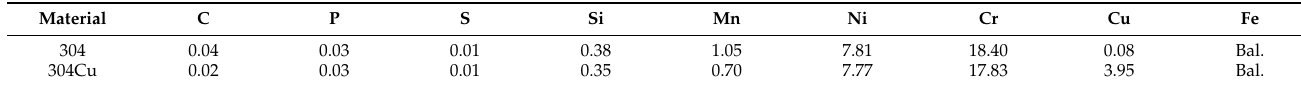
Table 1. Chemical composition of materials